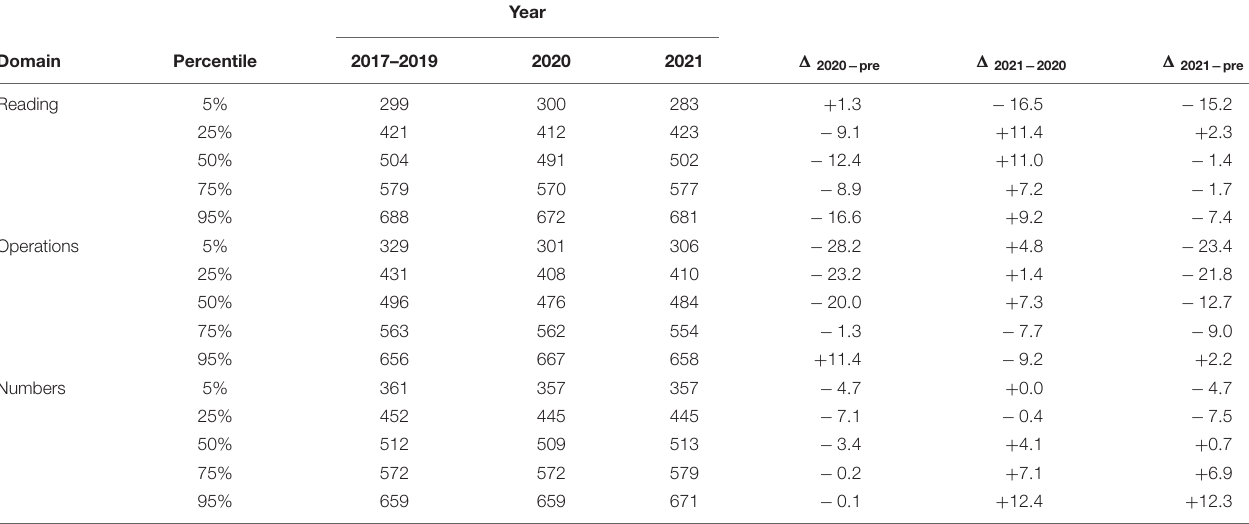
TABLE 3 | Selected percentiles for the competence distributions across years in reading and mathematics (see Figure 2